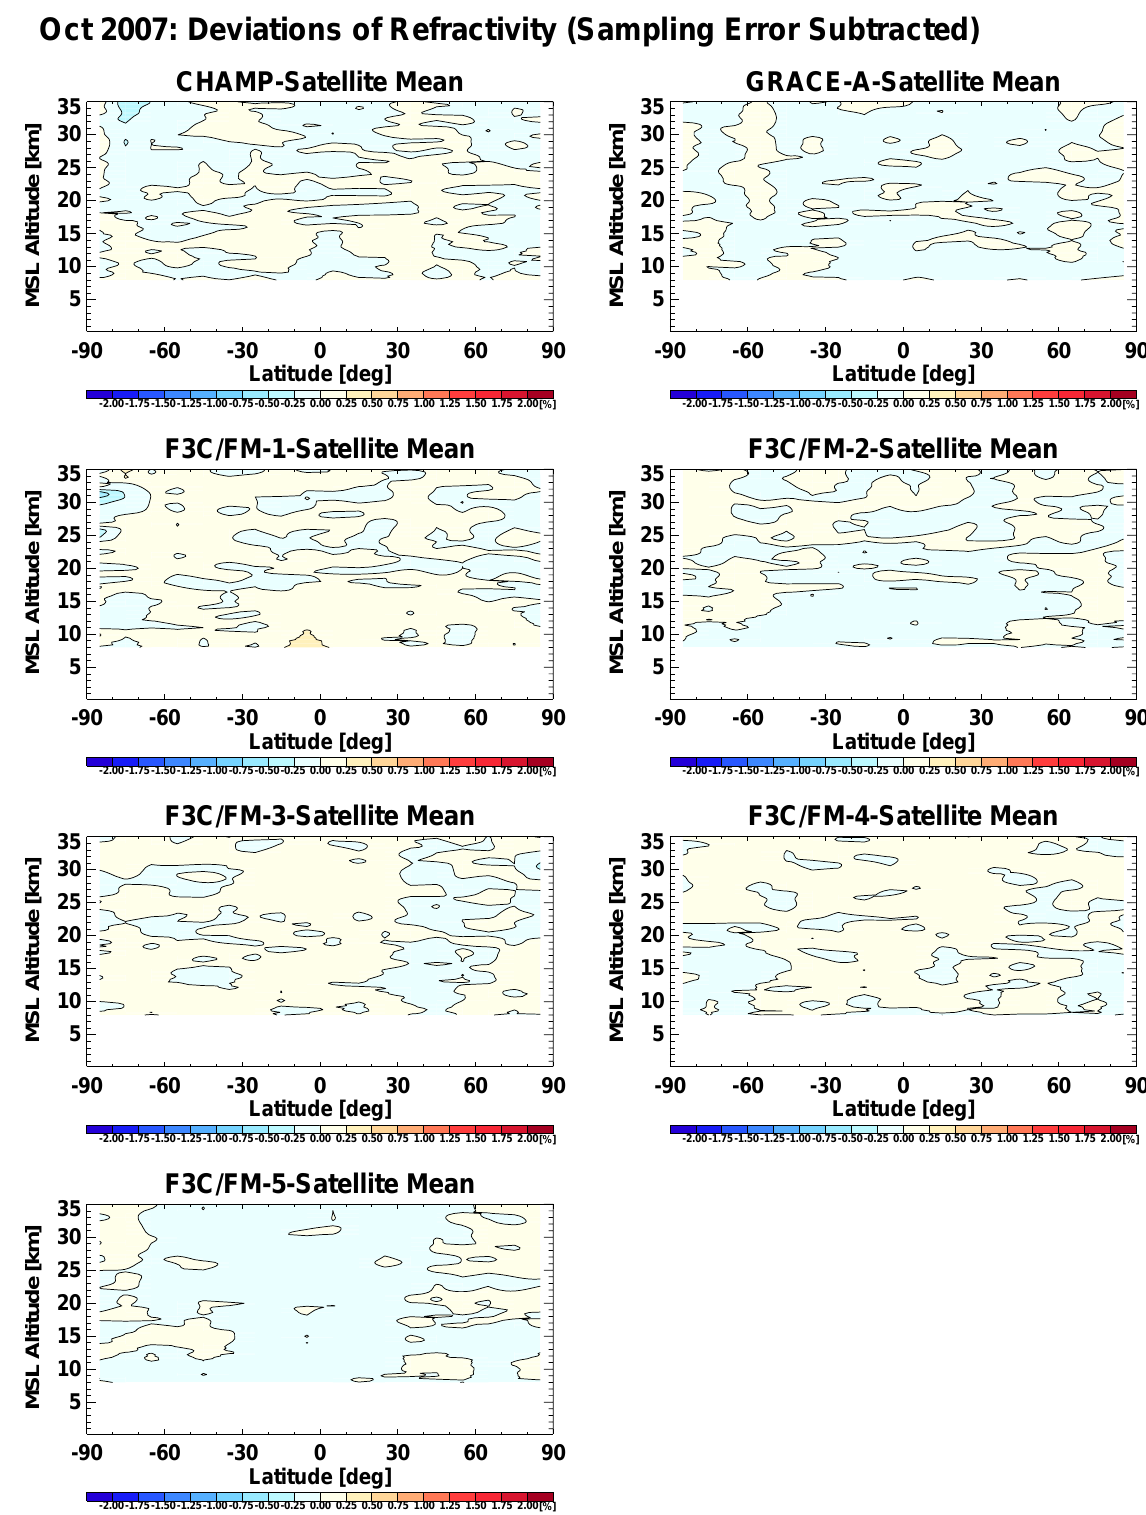
Fig. 3. Monthly mean relative refractivity deviations from the multi-satellite mean for October 2007 for the same satellites as in Fig. 2 but with the respective sampling errors subtracted.